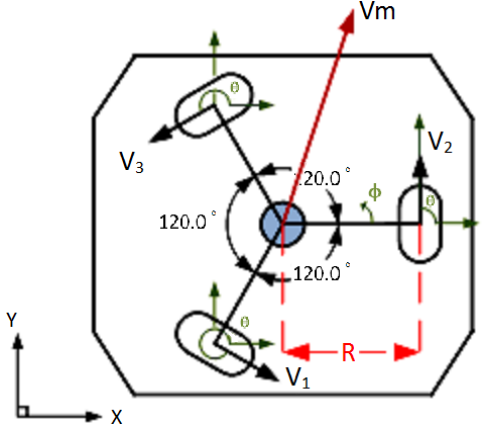
Figure 5. Configuration of the omni-directional mobile robot.